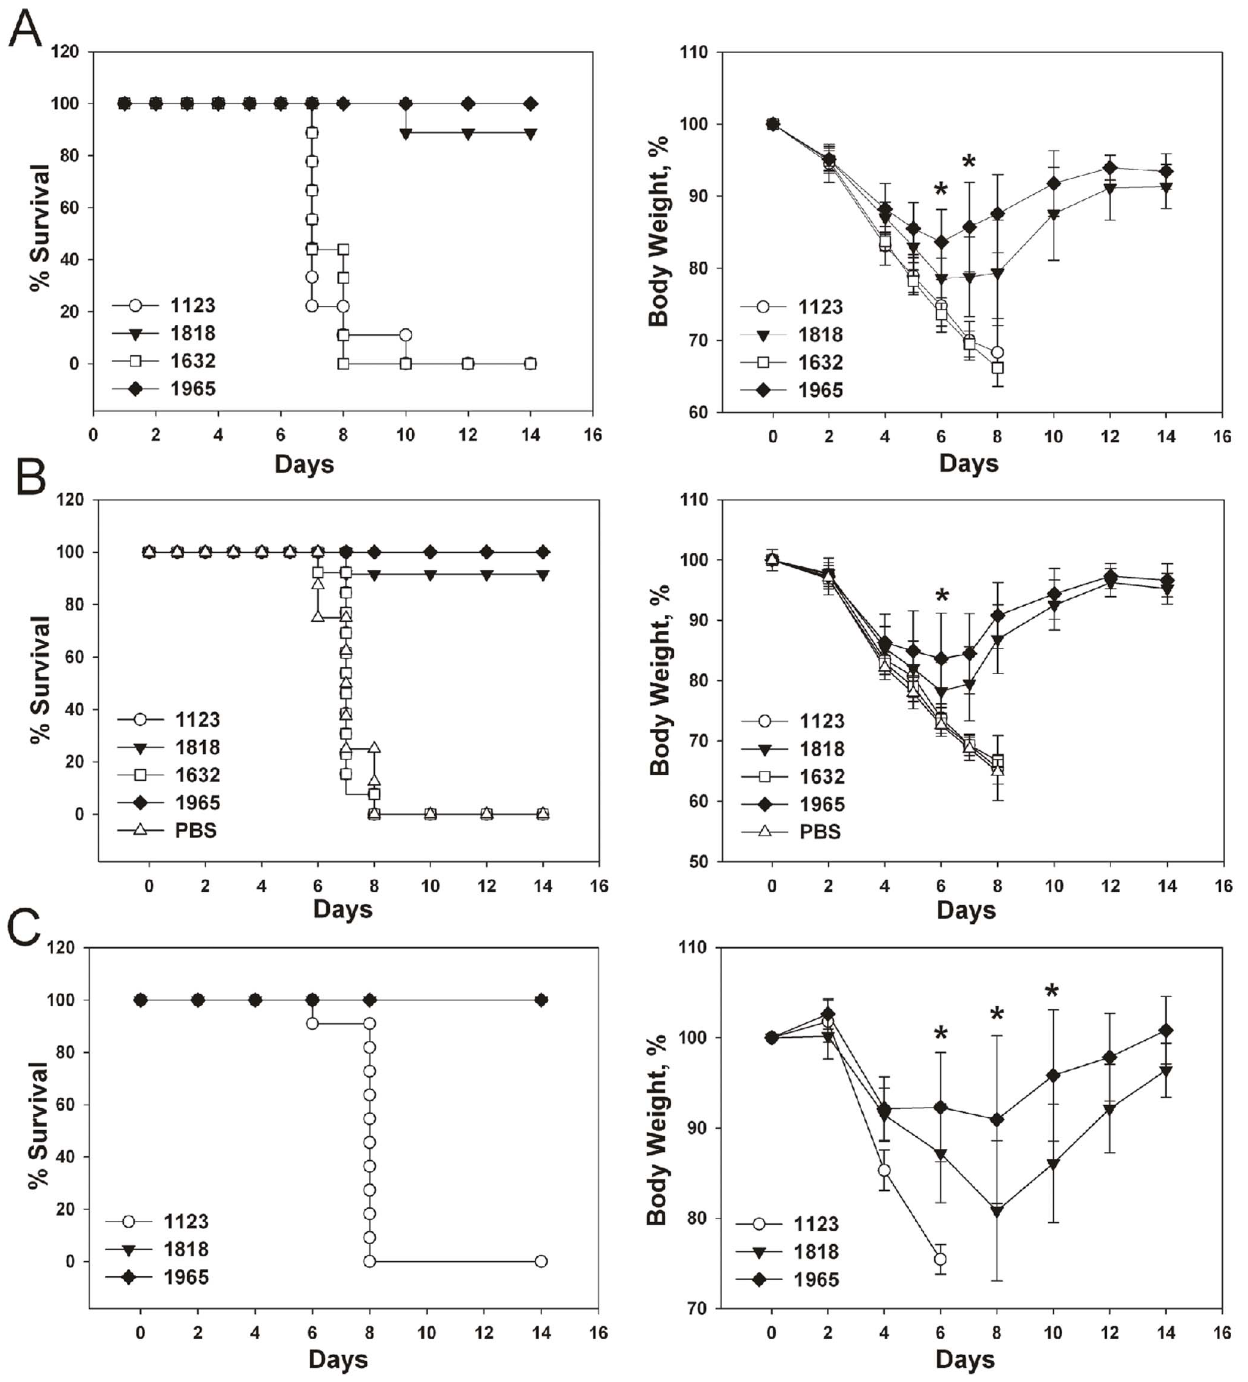
Figure 5. Immunization with VLP-1965 provides better protection against morbidity caused by influenza A virus challenge than VLP-1818. A. Groups of 12 BALB/c mice were immunized twice with an interval of three weeks with 10 m g of the indicated VLPs, adjuvanted with Alhydrogel. Three weeks after the second immunization, mice were challenged with 4 LD 50 of mouse-adapted X47 virus. Survival rate (left; P , 0.001, Kaplan Meier test) and body weight (right; P , 0.05, two-sample t-test on days 6 and 7 after challenge) were monitored for two weeks starting from the day of challenge. B. Groups of 8 (PBS), 12 (VLP-1818) or 13 (VLP-1965, -1632 and -1123) BALB/c mice were immunized twice with a two-week interval with 10 m g of the indicated VLPs, adjuvanted with Alhydrogel. One group of mice received PBS with Alhydrogel (PBS). Two weeks after the second immunization, mice were challenged with 4 LD 50 of mouse-adapted X47 virus. Survival rate (left; P , 0.001, Kaplan Meier test) and body weight (right; P , 0.05, two-sample t-test on days 6 after challenge) C. Groups of 14 BALB/c mice were immunized three times with three-week intervals by i.p. injection of 10 m g of VLP-1123, VLP-1818 or VLP-1965, adjuvanted with Alhydrogel. Three weeks after the second boost, mice were challenged with 4 LD 50 of PR/8 virus. Survival rate (left; P , 0.0001) and body weight (right; P , 0.05 on days 8, 10 and 12 after challenge).